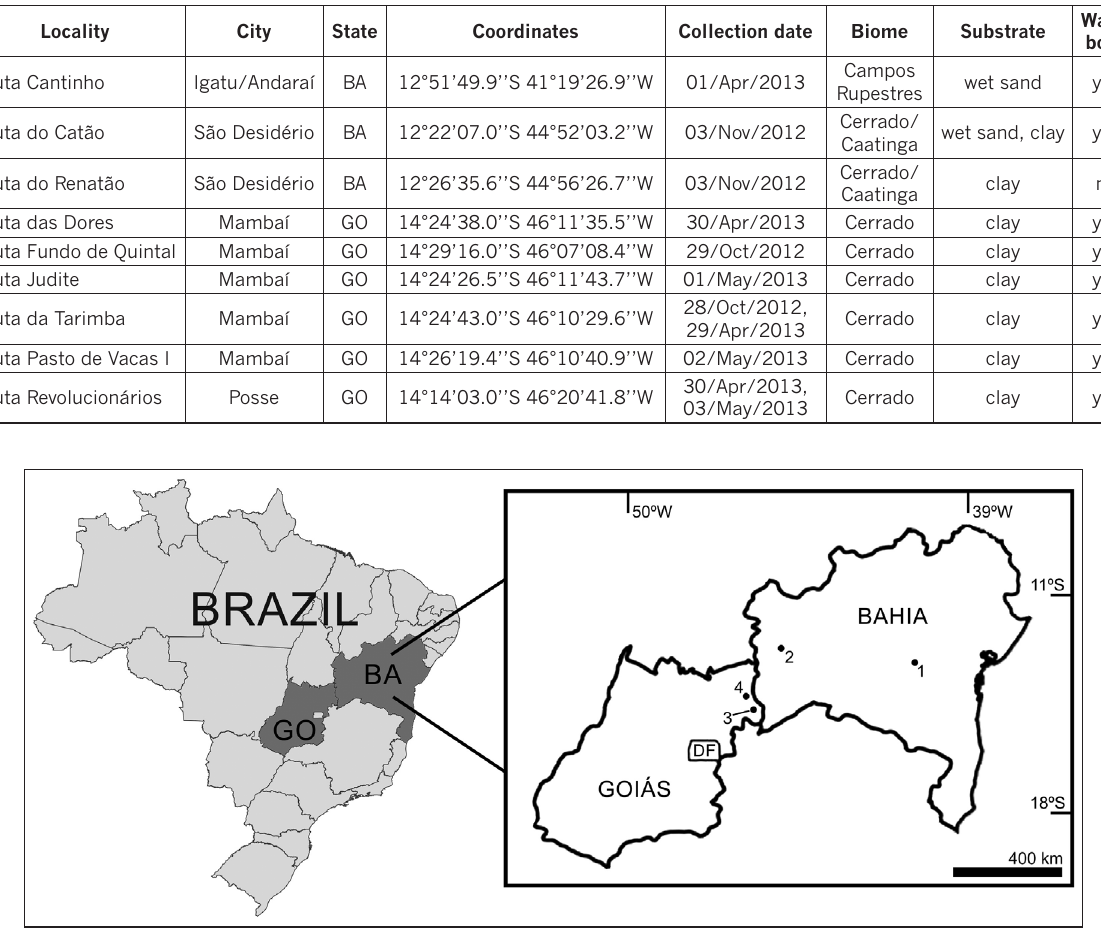
Figure 1. Map showing the Brazilian states of Bahia and Goiás, with the cities where the caves are located (see also Table 1): 1 , Igatu/Andaraí; 2 , São Desidério; 3 , Mambaí; 4 , Posse. Abbreviations: GO, Goiás state; BA, Bahia state; DF, Distrito